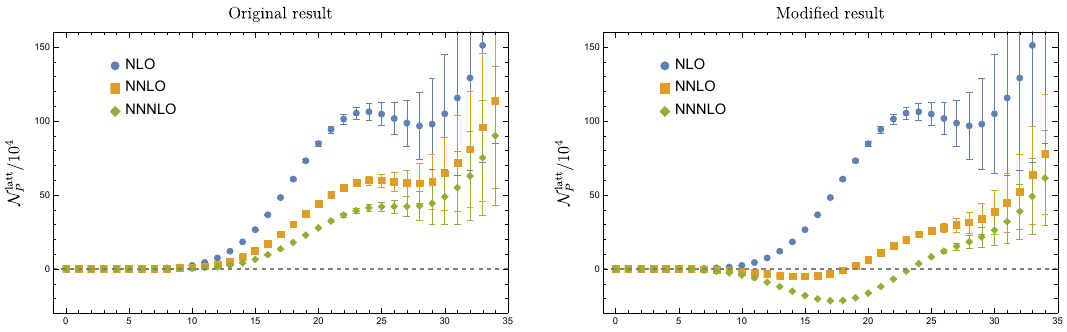
Figure 5 . Left panel: results as a function of order for the GC renormalon norm of the average plaquette obtained in ref. [20]. Right panel: the corresponding results when the 1 /n subleading asymptotic corrections are consistently expanded. In blue we show results at NLO, in orange at NNLO and in green at